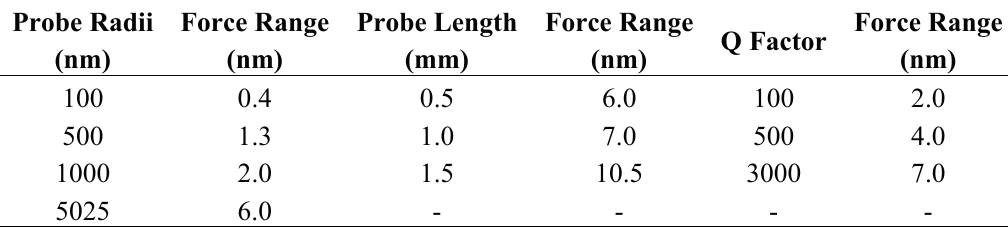
Table 10. Force sensitivity with the probe radii, probe length, and Q